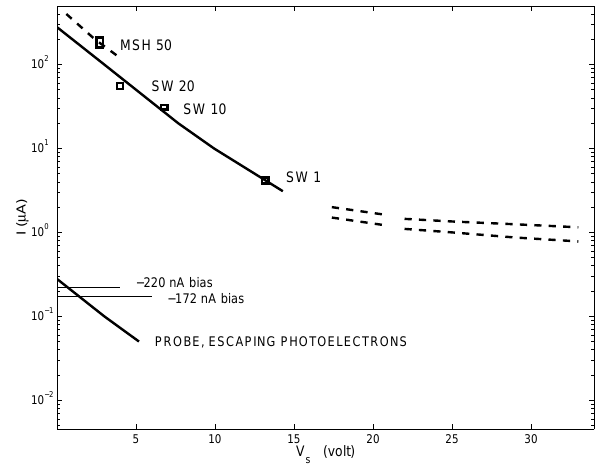
Fig. 2. Lower part: probe photoelectron current plotted against probe potential, and two bias curents of − 172nA and − 220nA. The current balance results in probe potentials of 1.2V and 0.7V, respectively. Upper part: spacecraft photoelectron characteristic, determined from Whisper solar wind and magnetosheath electron densities. Electron energy is assumed to be 16eV in the solar wind and in the range of 30–50 eV in the magnetosheath. Symbols are the following: SW1 is 1cm − 3 , SW10 is 10cm − 3 and SW20 is 20cm − 3 in the solar wind. MSH 50 is 50cm − 3 in the magne- tosheath. The squares mark values of currents to the spacecraft for solar wind and magnetosheath plasma accelerated to the spacecraft for the corresponding measured V s − V p values. The dotted lines are extensions of the photoelectron characteristics to spacecraft volt- ages up to 33V. See text for detailed